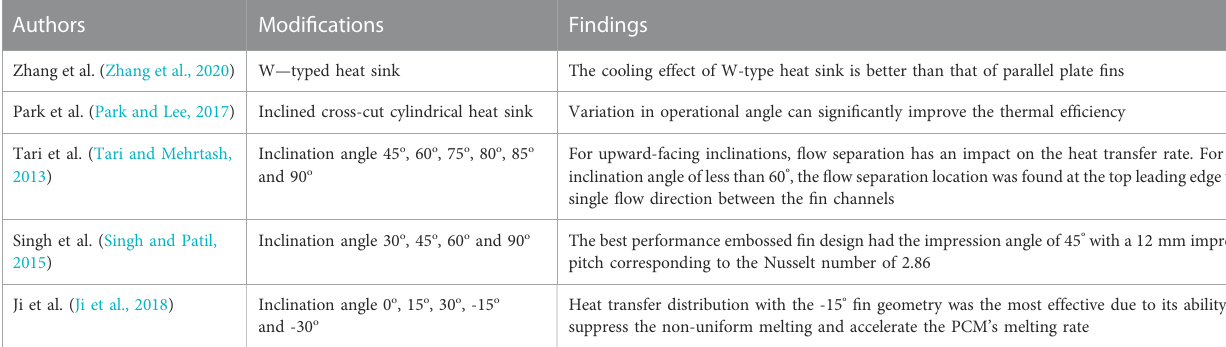
TABLE 2 Summary of work on inclined fi n